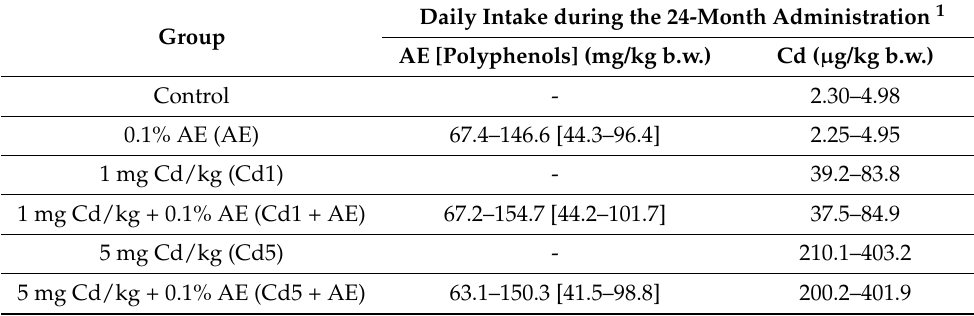
Table 1. The ranges of the daily intakes of AE, polyphenols, and Cd during the 24-month experiment 1 . Daily Intake during the 24-Month Administration Group